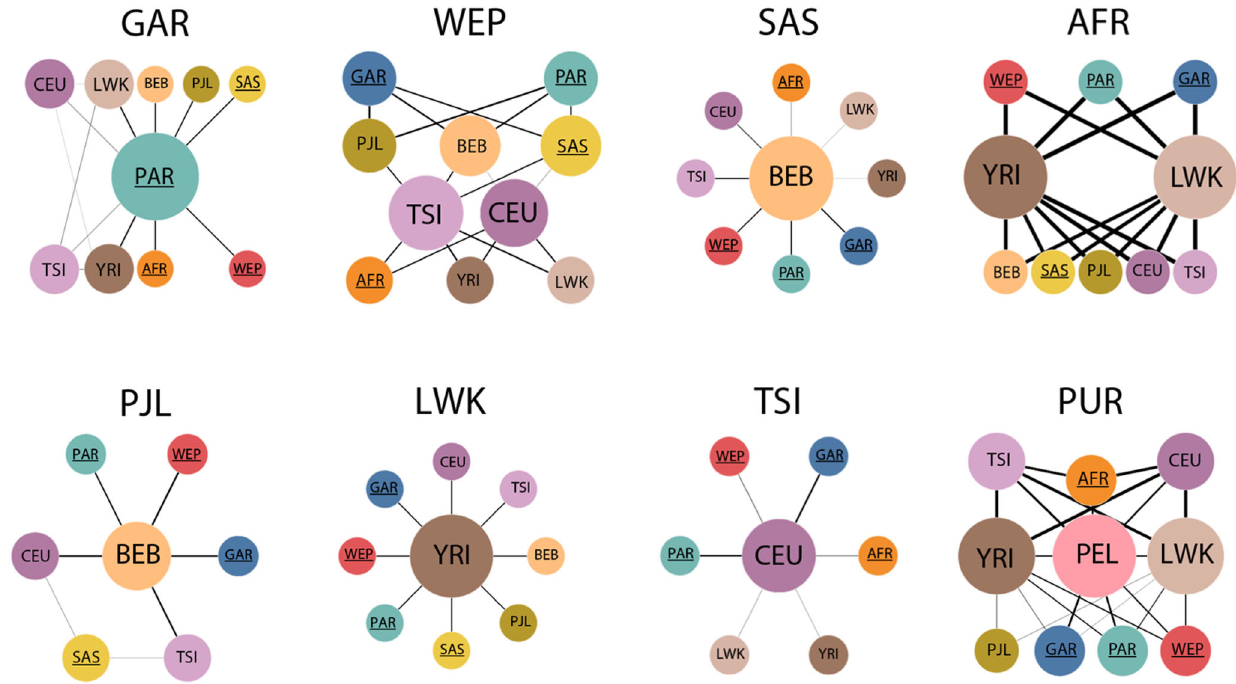
Fig. 2 Contribution of Arab populations to various modern continental populations and vice versa. Large headers show populations from QGP (top) and 1KG (bottom) which are a signi fi cant target for admixture by other populations from the combined datasets. For each target population, a network is depicted for the underlying pairs of donor populations with a signi fi cant F3 statistic (Z < -3). Edge thickness is proportional to absolute Z score and circle size is proportional to the number of connecting edges. Edge length is arbitrary. QGP subpopulations are labeled with an underscore. Abbreviations of 1KG populations are explained in Supplementary Table 2. Source data are provided as a Source Data fi